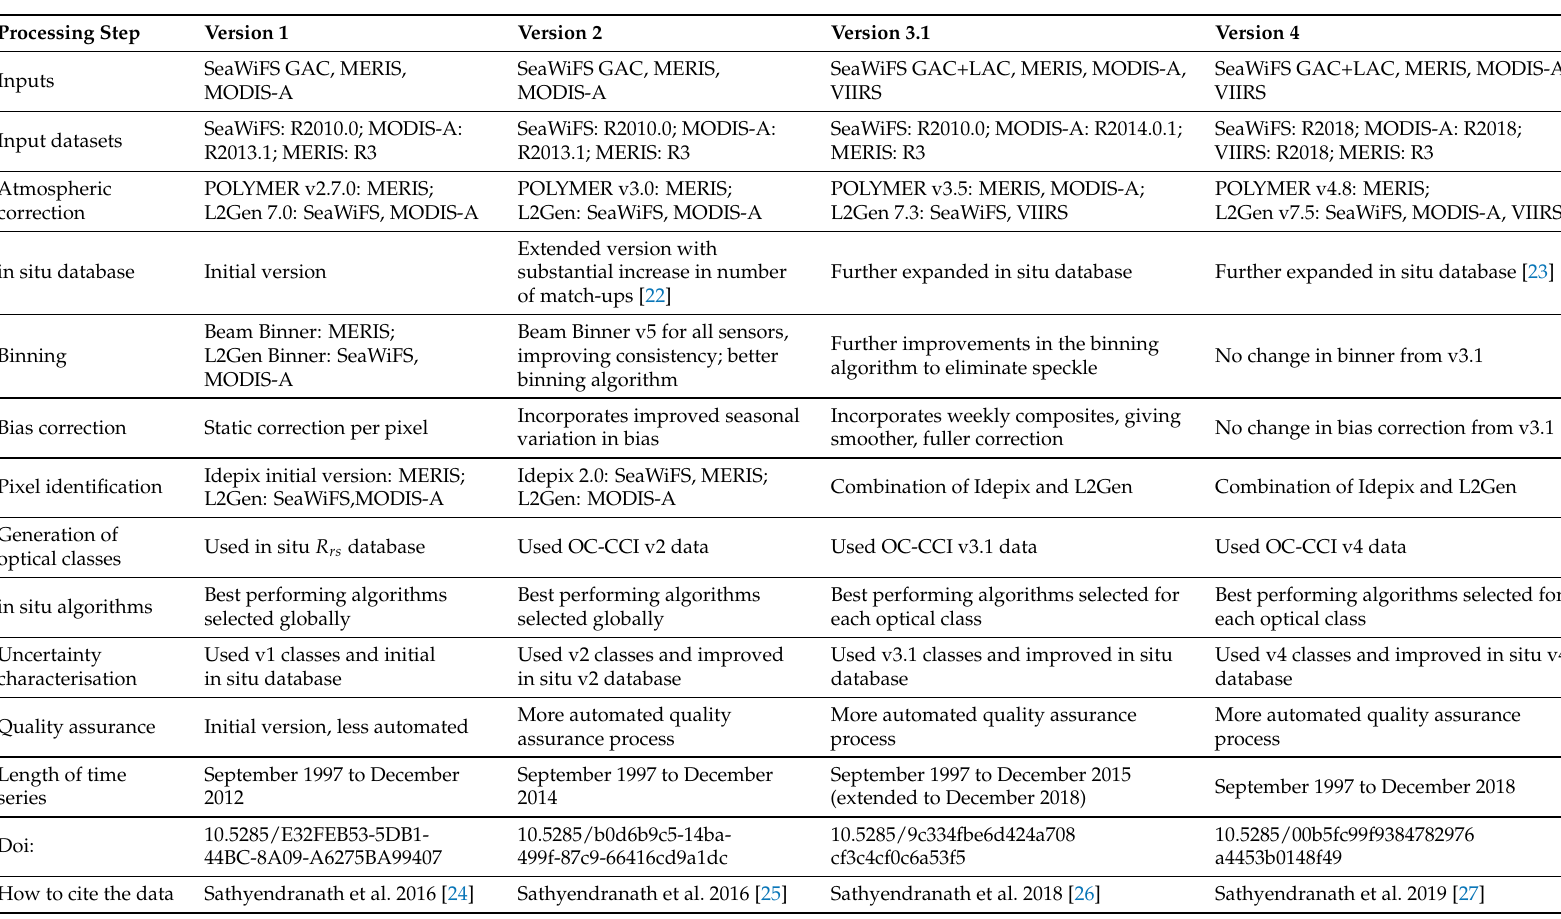
Table 2. Properties and modifications of processing steps for successive versions of Ocean-Colour Climate Change Initiative (OC-CCI): For further information on the OC-CCI Project and related documents, please visit esa-oceancolour-cci.org. Tools for data subsetting, visualisation, and downloading (ftp, web GIS, OPeNDAP, and composite browser) are also available at oceancolour.org (Supplementary Materials). Support is available from help@esa-oceancolour-cci.org. Access to other essential climate variable (ECV) data and a toolbox for data analyses are available through the climate change initiative (CCI) open data portal